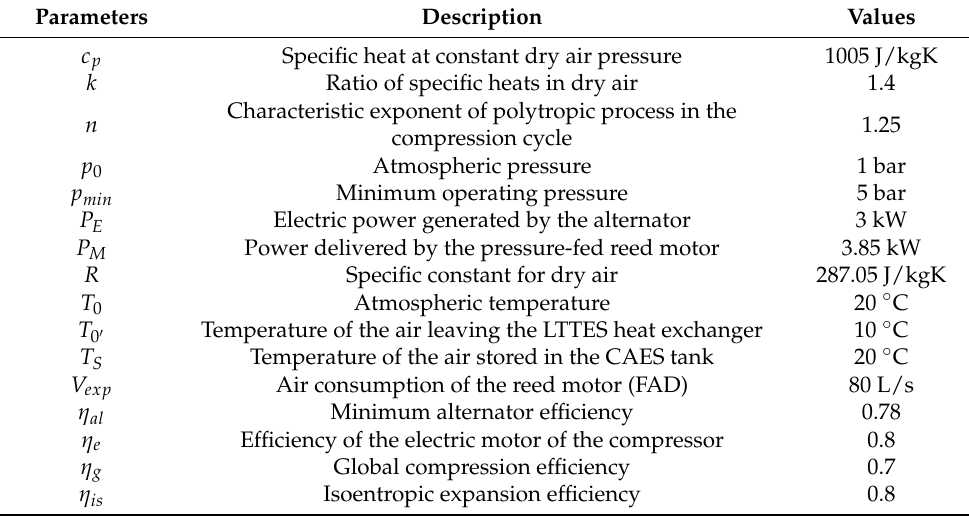
Table 1. Thermodynamic coefficients and parameters that are not subject to optimization.